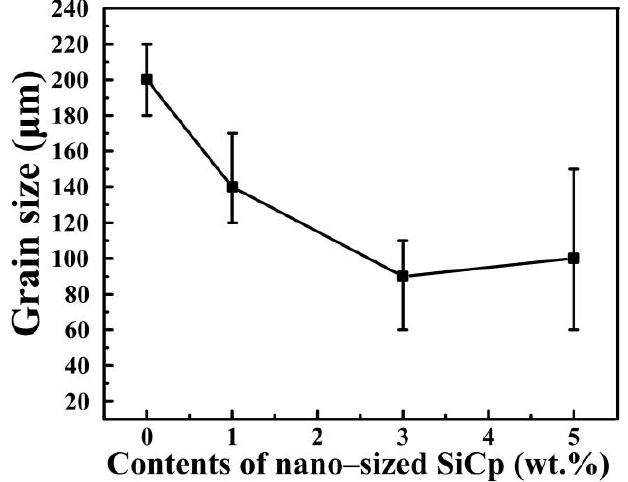
Figure 2. Grain sizes of α -Al in the cast Al–Cu alloy and nano-sized SiC p /Al–Cu composites with different SiC p contents.